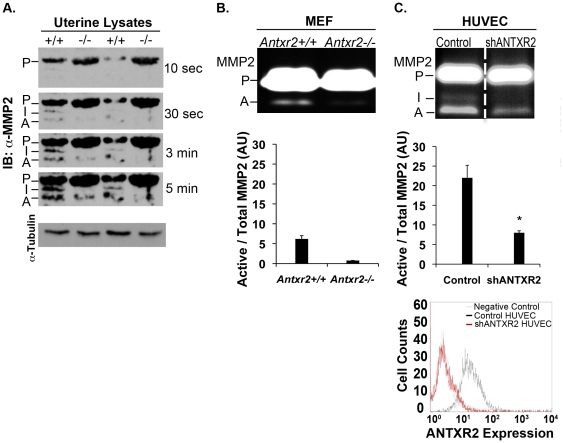
Reduced MMP2 activity in Antxr2 deficient tissue and cells.(A) Uterine lysates from six-month-old mice, Antxr2+/+ (n = 2) and Antxr2−/− (n = 2), were immunoblotted for MMP2 and demonstrated that there are reduced levels of active MMP2 in the Antxr2−/− tissue (P = the pro form of MMP2, I = the intermediate form of MMP2 and A = the active form of MMP2). Alpha tubulin was used as a loading control. (B) Gelatin zymography revealed reduced levels of active MMP2 in conditioned medium from Antxr2−/− MEFs. A representative of two independent experiments is shown. For each experiment, samples were run in duplicate. The graph below the zymogram gel represents the relative levels of active to total MMP-2 (pro+intermediate+active) as quantified by densitometry and shows the mean ± standard deviation (P = .06). (C) Conditioned medium from HUVEC cell lines with knock down of ANTXR2 expression (shANTXR2 HUVEC) had reduced MMP2 activity as determined by gelatin zymography. The vertical dotted line reflects the fact that different parts of the same gel were placed next to each other in the figure for ease of comparison. A representative of two independent experiments is shown. For each experiment, the samples were run in quadruplicate. The graph below the zymogram gel represents the relative levels of active to total MMP-2 (pro+intermediate+active) as quantified by densitometry and shows the mean ± standard deviation (P<.05). The bottom panel is a histogram from flow cytometry analysis of retrovirally-infected HUVEC scrambled shRNA (control) or ANTXR2 shRNA (shANTXR2) cell lines. The histogram shows decreased ANTXR2 expression at the cell surface of the shANTXR2 HUVEC line.